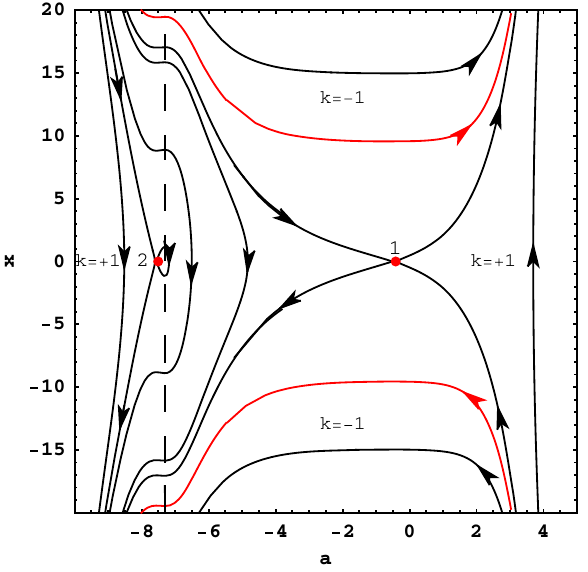
Fig. 14 The phase portrait of the system (86)–(87) for negative (cid:3) γ . The scale factor a is in logarithmic scale. The red trajectories repre- sent a spatially flat universe. Trajectories under the top red trajectory and below the bottom red trajectory represent models with a negative spatial curvature. Trajectories between the top and bottom red trajec- tory represent models with the positive spatial curvature. The dashed line b = 0 corresponds to the sudden singularity. The shaded region represents trajectories with b < 0. If we assume that f (cid:3) ( R ) > 0 then this region can be removed. The phase portrait possesses the symmetry ˙ a → −˙ a and in consequence this singularity presents a bounce. This symmetrycanbeusedtoidentifythecorrespondingpointsonthe b -line. The critical point (1) represents the static Einstein universe. The phase portrait belongs to the class of sewn dynamical systems [49]